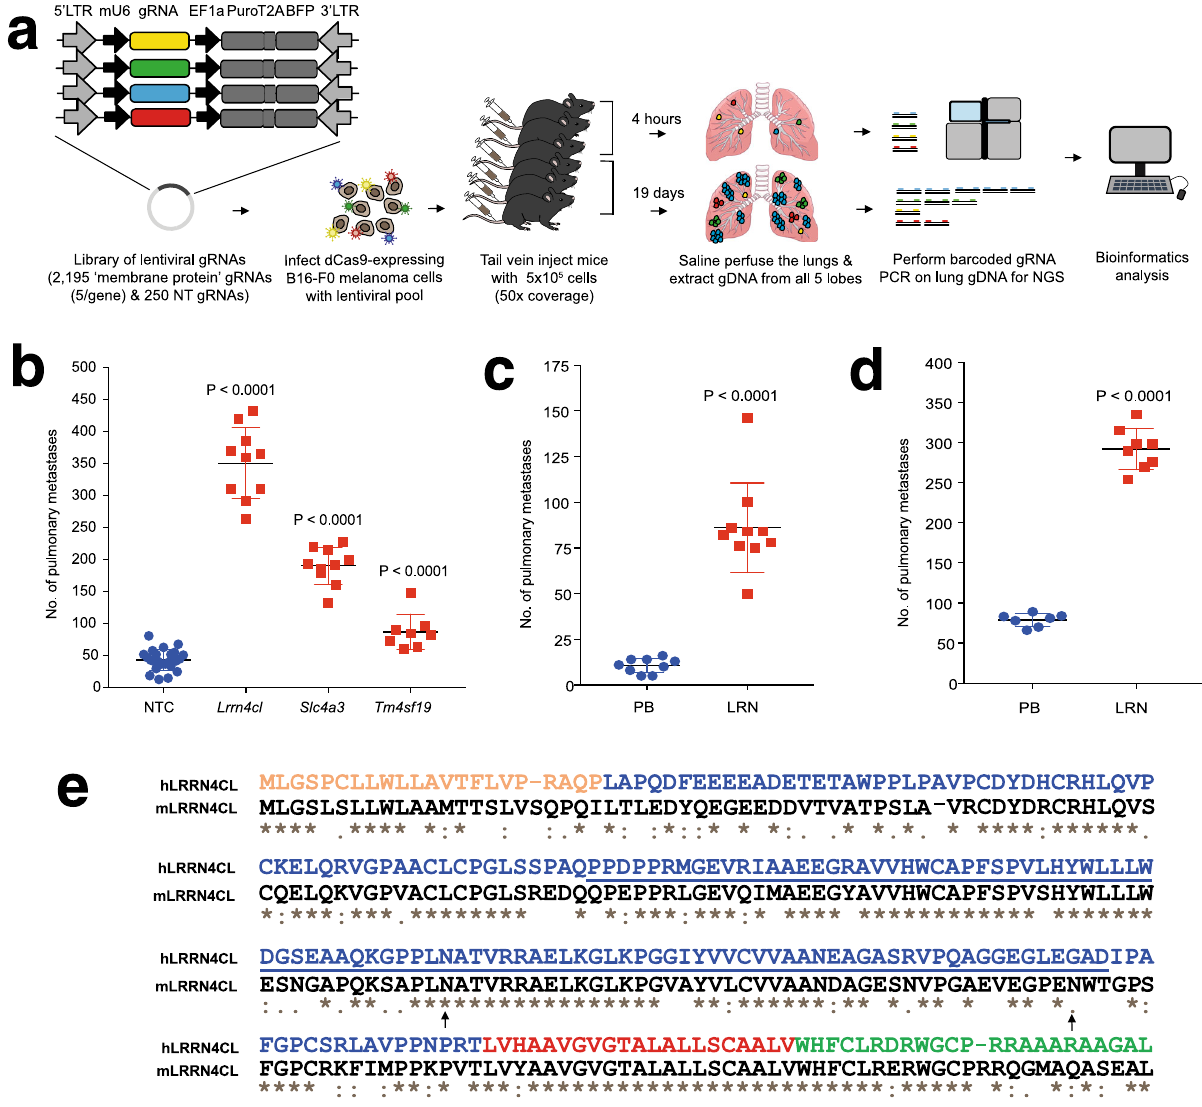
Fig. 1 Performing a CRISPRa screen in vivo to identify cell surface regulators of pulmonary metastatic colonisation. a Graphic representation of the screen outline. b The number of metastatic colonies in the lungs of mice 10 days after being tail vein dosed with 2 × 10 5 B16-F0-dCas9 cells carrying gRNAs against the genes listed. NTC, non-targeting control. c The number of metastatic colonies in the lungs of mice 10 days after being tail vein dosed with 1 × 10 5 B16-F0 cells that have been stably transfected with a plasmid carrying the Lrrn4cl cDNA (LRN) or an empty vector (PB). d The number of metastatic colonies in the lungs of mice 10 days after being tail vein dosed with 4 × 10 5 B16-F0 cells that have been stably transfected with a vector carrying the Lrrn4cl cDNA (LRN) or an empty vector (PB). For (b-d), each symbol represents a mouse, the bars represent mean ± SD, 2 independent experiments performed (representative data from one experiment is shown) and statistics performed using a Mann – Whitney t test. e The human and mouse LRRN4CL protein sequences (ENSP00000325808 and ENSMUSP00000093976, respectively) were aligned CLUSTAL W (1.81) in Ensembl. Below each site amino acid of the alignment is a key denoting conserved sites (*), sites with conservative replacements (:), sites with semi-conservative replacements (.), and sites with non-conservative replacements (). The UniProtKB predicted location of the signal peptide (orange), extracellular domain (blue), transmembrane domain (red), cytoplasmic domain (green), FN3 domain (underlined) and N-linked glycosylation site at N132 (arrow) for human LRRN4CL are shown (glycosylation sites for the mouse also shown: arrows at N132 and expression is in the endometrium and ovary, with a mean of 5.9 RPKM for each) (Supplementary Fig. 2d), in agreement with proteomic data from the Human Proteome Map. We next generated and phenotyped Lrrn4cl knockout mice, fi nding them to be homozygous viable and fertile, in agreement with other studies 13 and displaying no gross differences compared with wildtype control mice in body weight, soft tissue mass, lean mass, fat mass, bone mineral content or bone mineral density (Supplementary Fig. 2e). Both of these factors are critical for LRRN4CL to be considered as a therapeutic target.